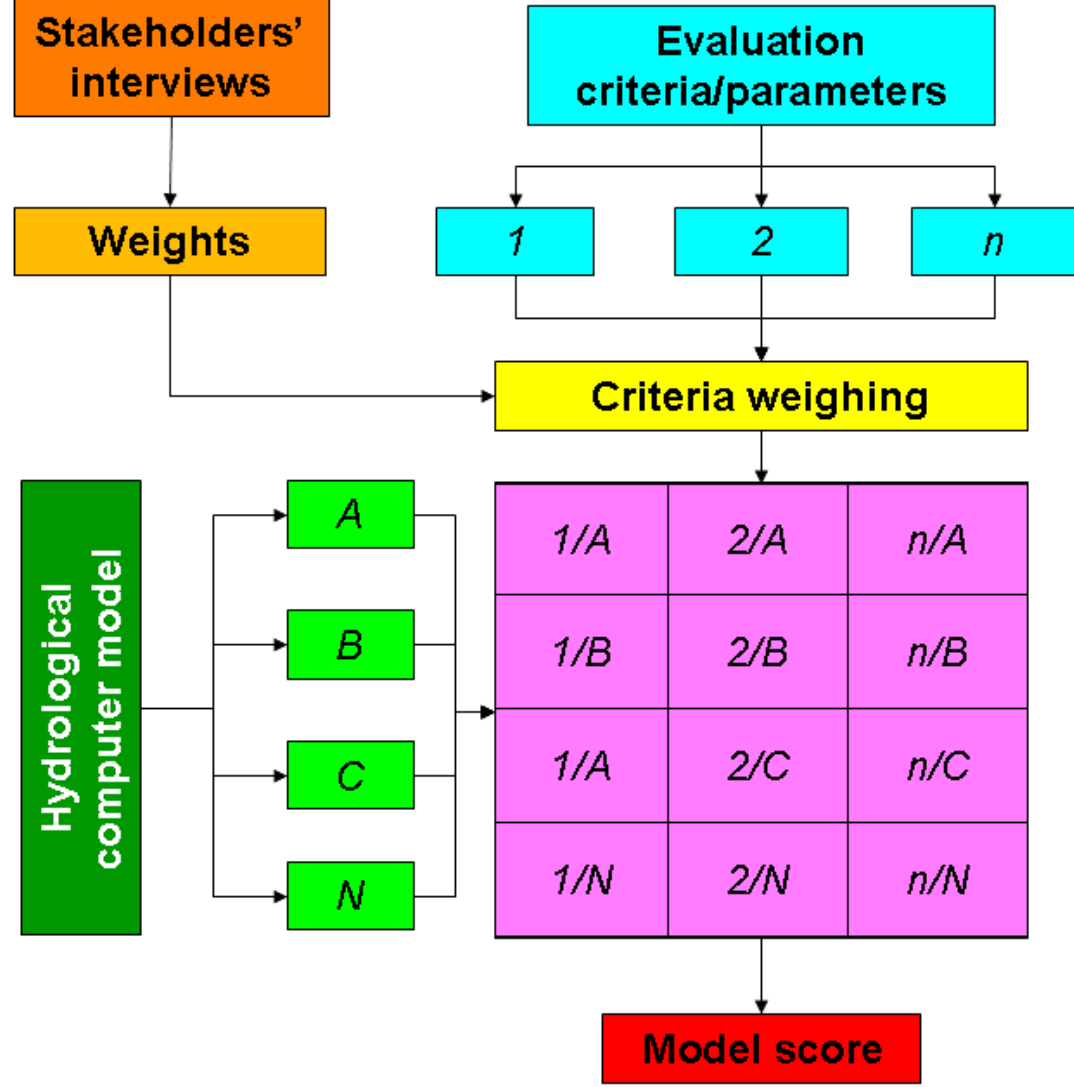
Figure 1. Location and digital elevation model of the Mesima torrent (Calabria, Southern Figure 1 . The evaluation matrix of models proposed in this study.